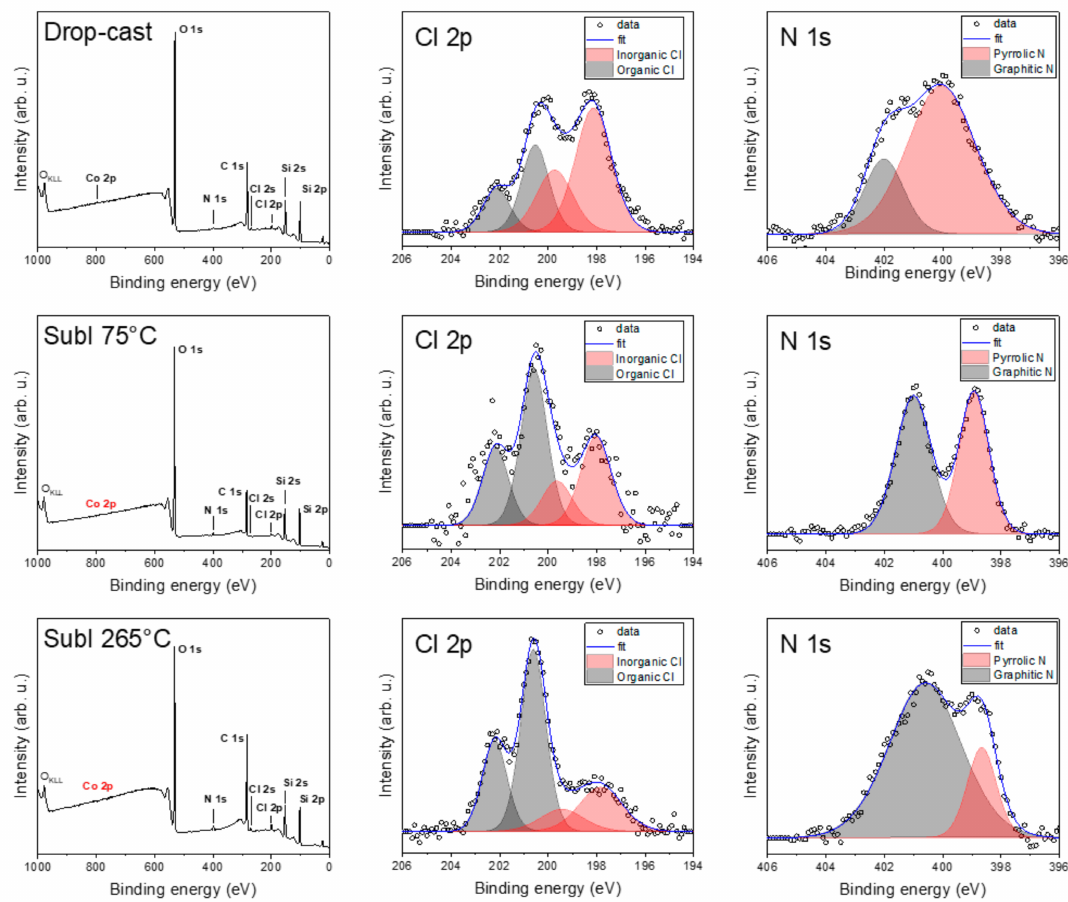
Figure 6. Comparison of detailed XPS spectra of drop-cast and sublimated samples at 75 and 265 ◦